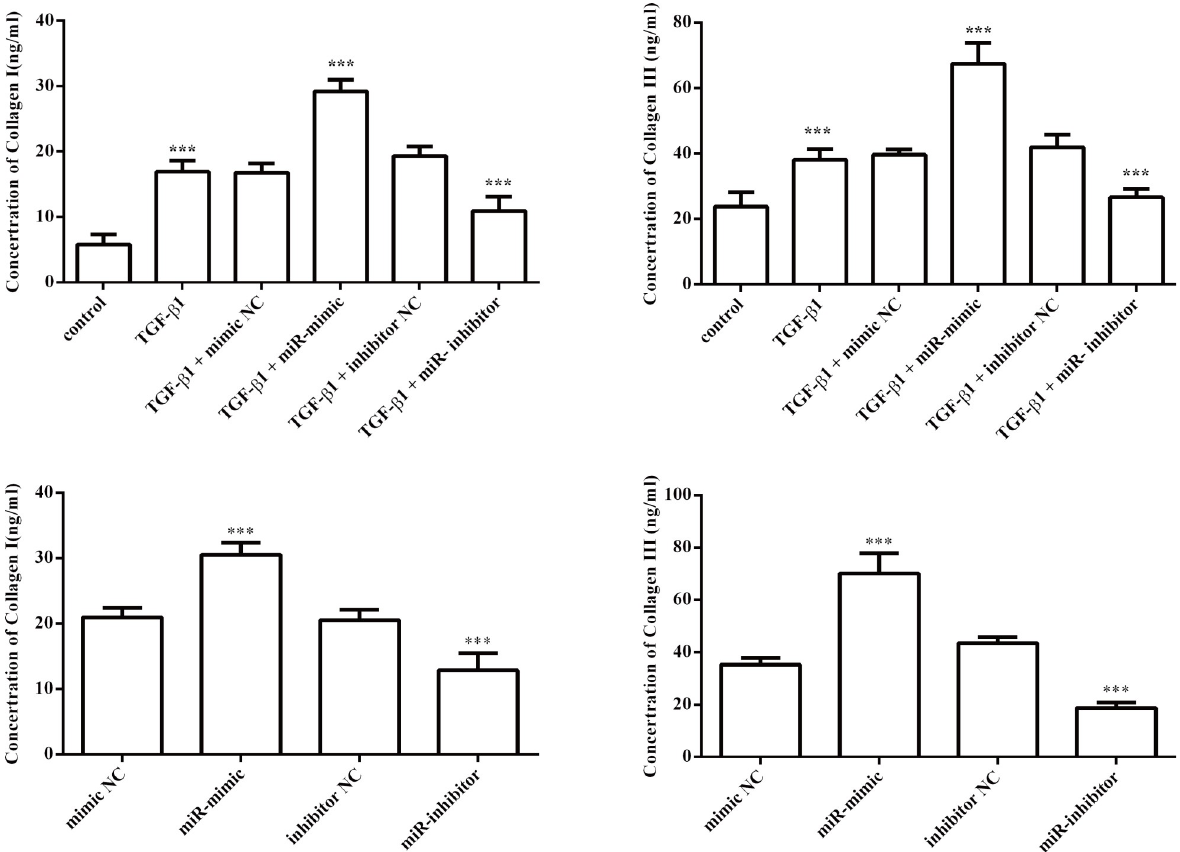
Fig 4. Effects of miR-1202 on collagen synthesis of HCFs treated with or without TGF- β 1. The expression levels of collagen I and collagen III in HCFs treated with TGF- β 1 (A) or in HCFs without TGF- β 1 (B) were assessed by ELISA assay. All of the data are expressed as the mean ± SD. Compared with the control group, n = 3, � P < 0.05; �� P < 0.01, ��� P < 0.001. The analysis is not able to detect small significant differences due to small sample size.